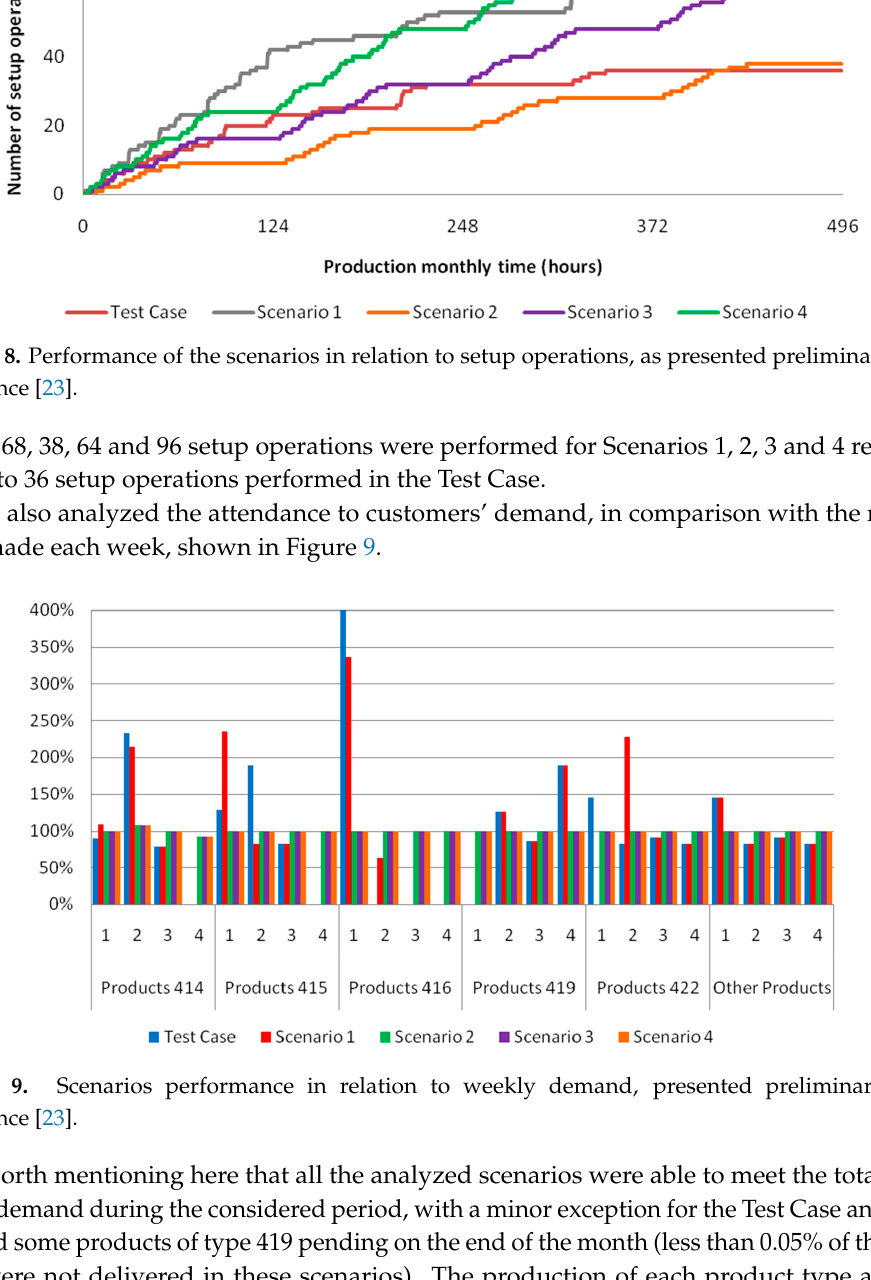
Figure 10. Scenarios performance in relation to machines utilization, as presented preliminarily in Reference [23]. Again the Test Case and Scenario 1 had similar performances, while the remaining three scenarios also had similar performances when compared to each other.